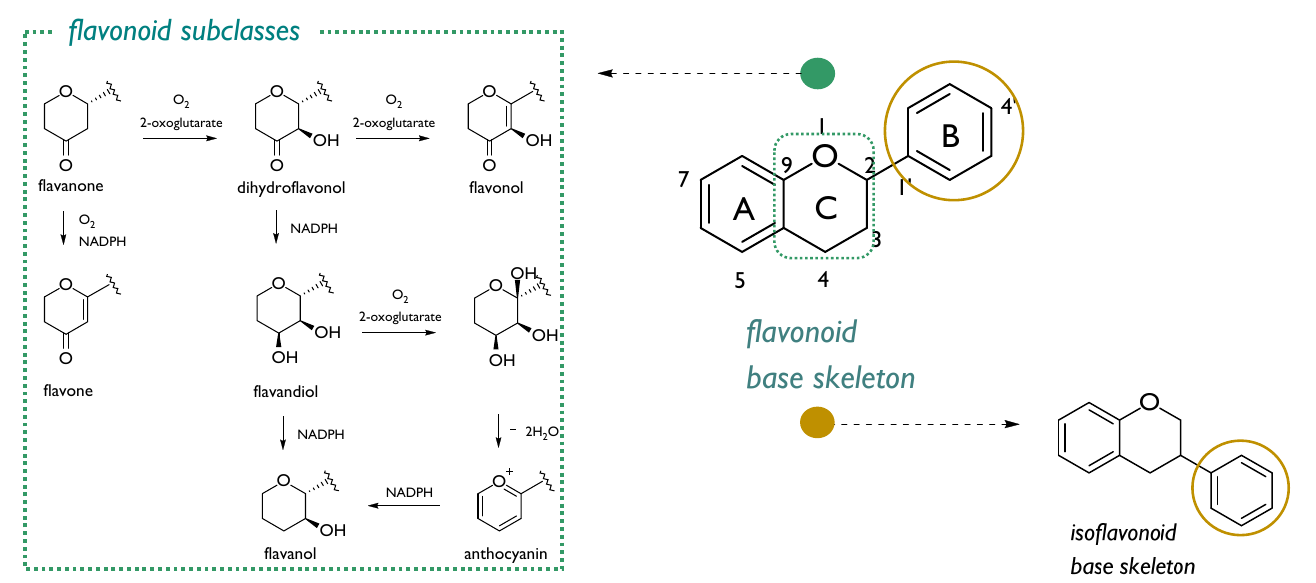
Figure 3. Flavonoid base skeleton and structural modifications of ring C which led to different flavonoid subclasses (green box). Isofavonoids are from the 1,2-aryl shift (yellow circle).